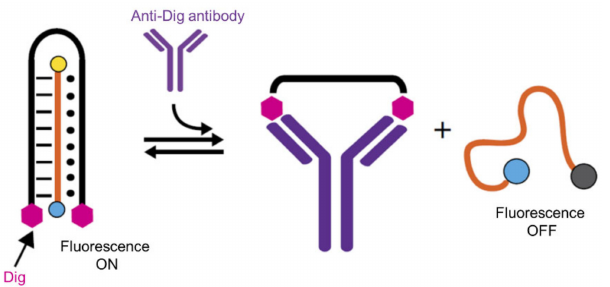
Figure 12. Conceptual scheme of antibody-powered DNA nanomachine capable of antibody detec- tion